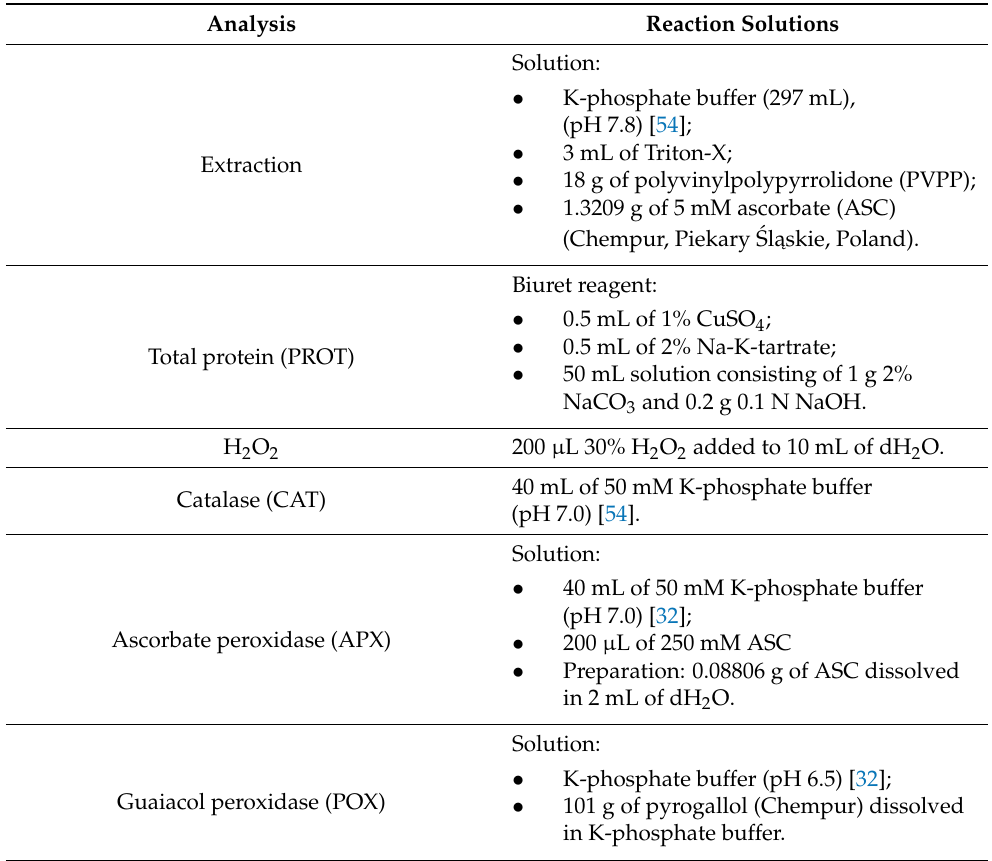
Table 1. Composition of reaction buffers used for antioxidant enzyme